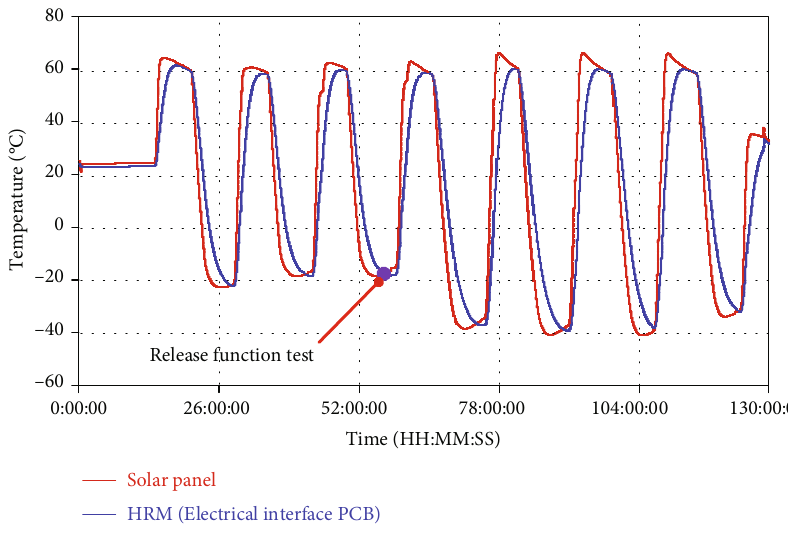
Figure 14: Time histories of the temperature pro fi les of the solar panel module in the TV test.